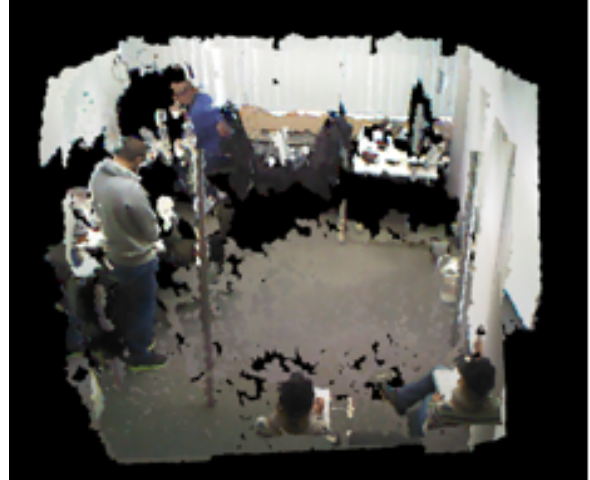
Figure 10: Stitched point cloud coming from all four Kinect sen- sors